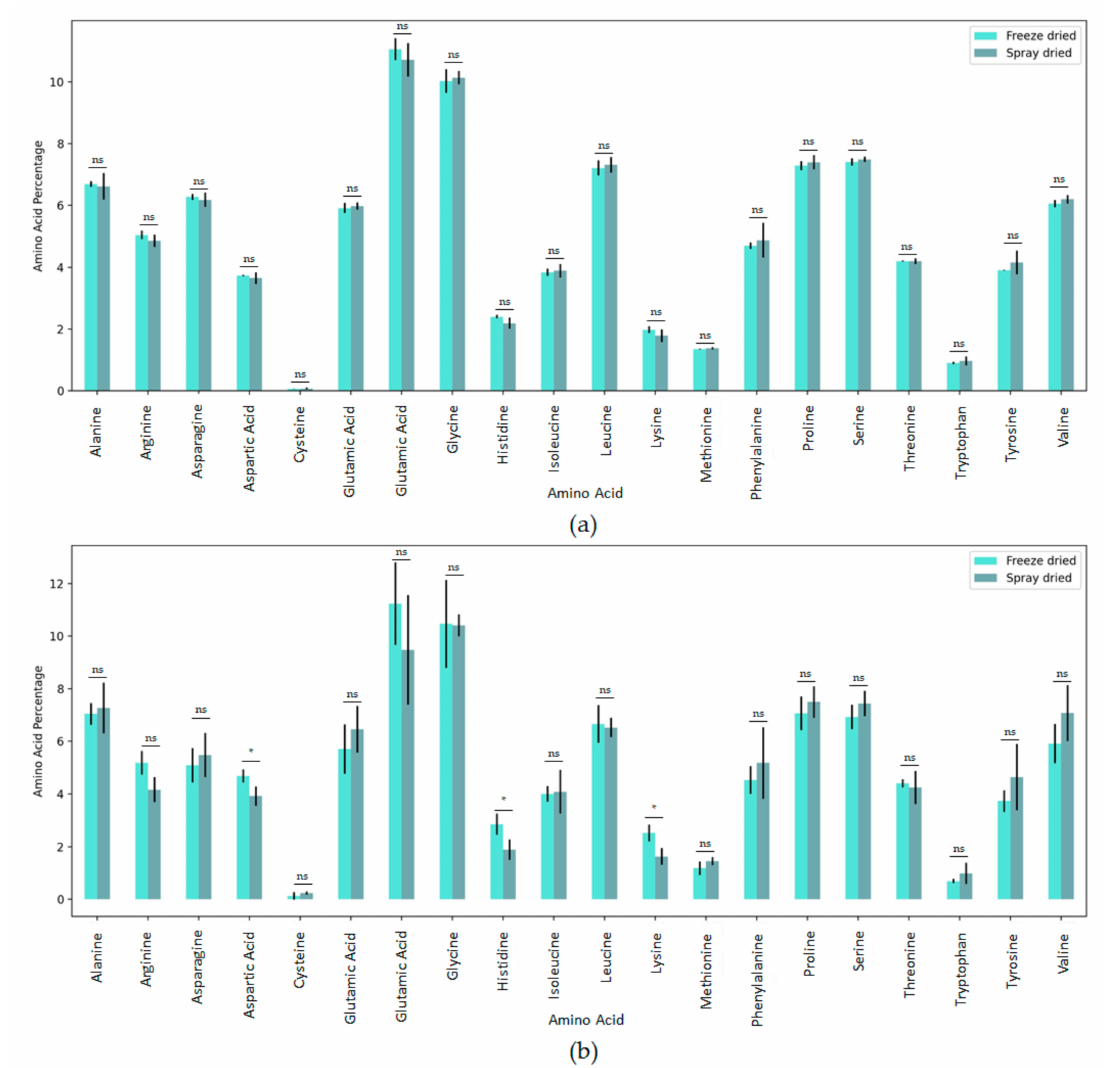
Figure 2. Amino Acid distribution in FD and SD samples of rice NPN. Total amount of amino acid (%) for each amino acid within ( a ) peptides present in full samples and ( b ) peptides exclusive in either FD (teal bar) or SD (blue bar) samples. Analysis was carried out using a Student’s t test (data represented at mean ± STD; ns, not significant; * p <